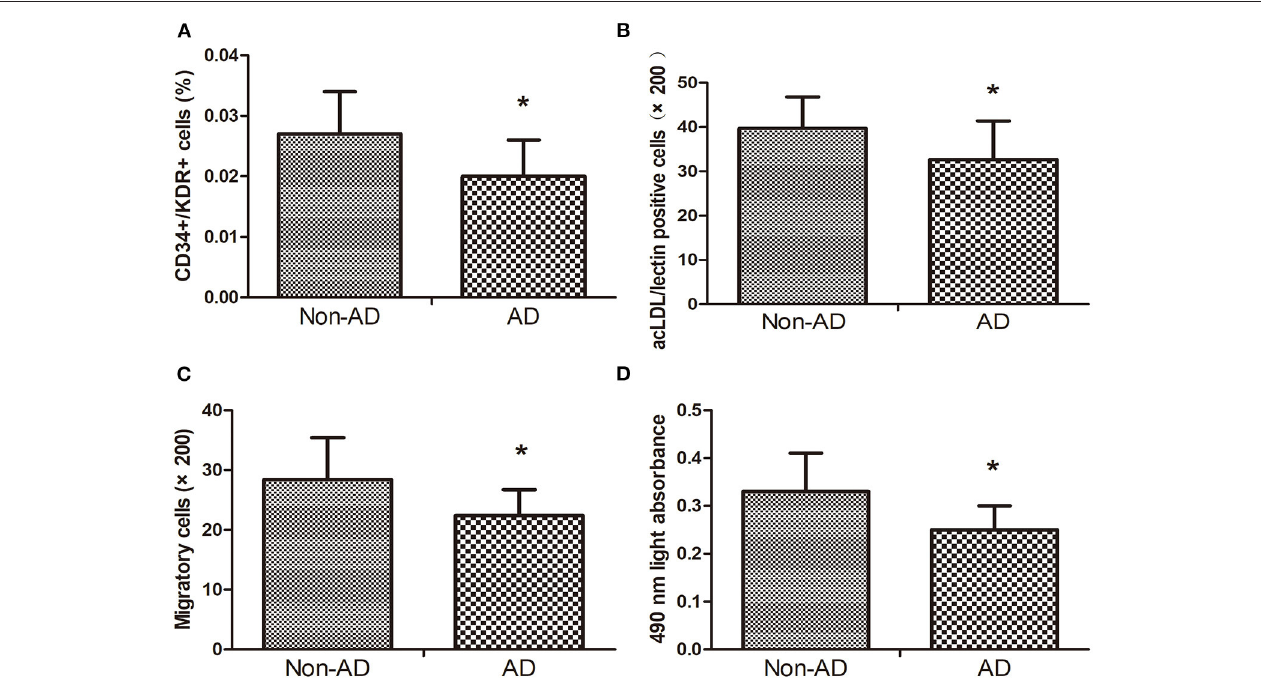
FIGURE 1 | The CD34 + KDR + positive cells (A) and DiI-acLDL/lectin positive cells (B) in AD subjects were lower than those in Non-AD subjects. The migratory (C) and proliferative (D) activities of EPCs in AD subjects decreased when compared with Non-AD subjects. Data are given as the mean ± standard deviation (SD). * p < 0 05 vs. Non-AD